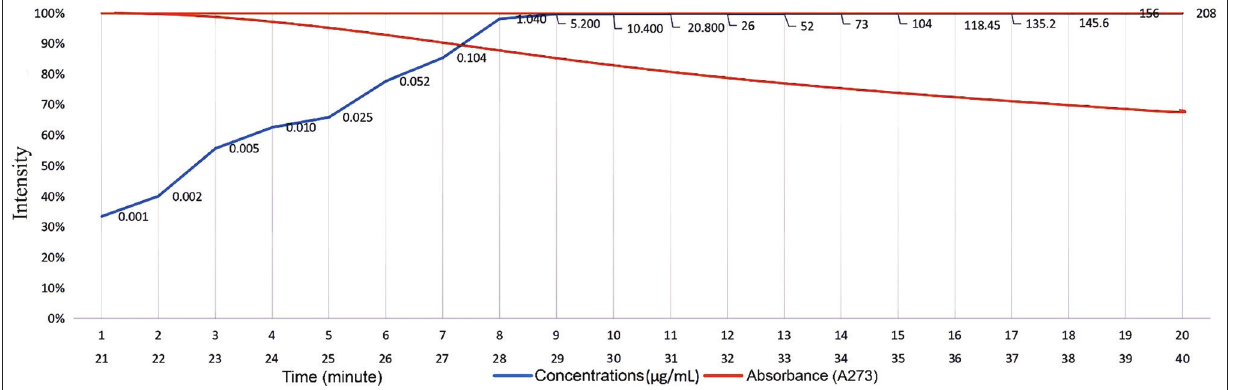
Figure-2: Stability test of intensity absorbance of tetracycline certified reference material on ranging 0.001-208 μg/mL in 0.1 N HCl (w/v) during the 40 min observed. the yellow color with a faint yellow color quality at tetracycline concentrations between 45 μ g/mL and 50 μ g/mL (Table-1). The 50% end point of concentrate